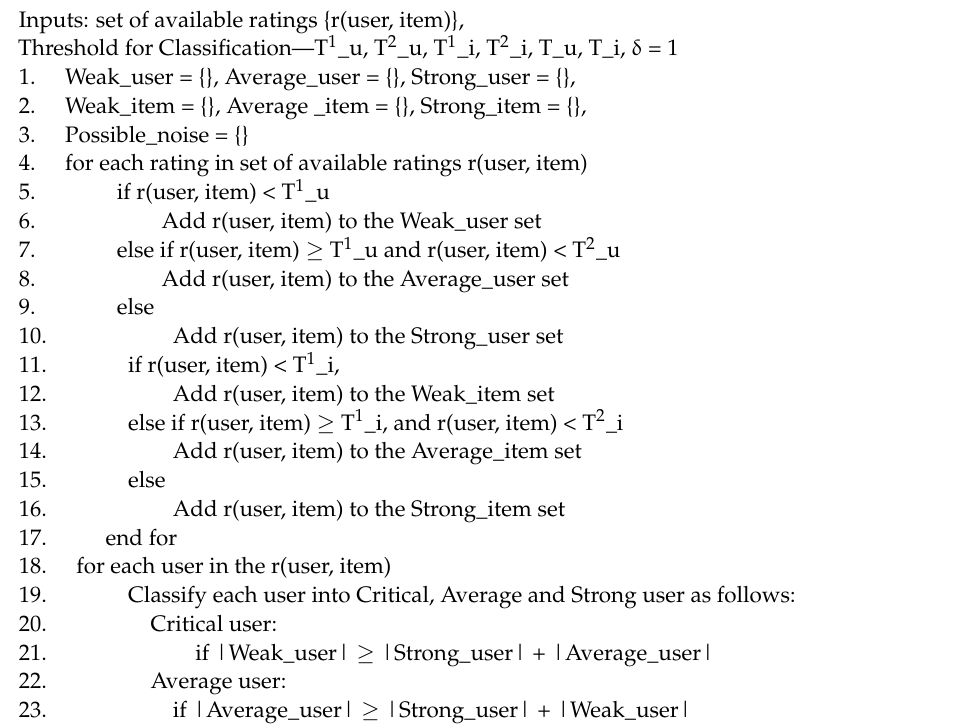
Algorithm 1: Steps of Detecting and Correcting Noisy